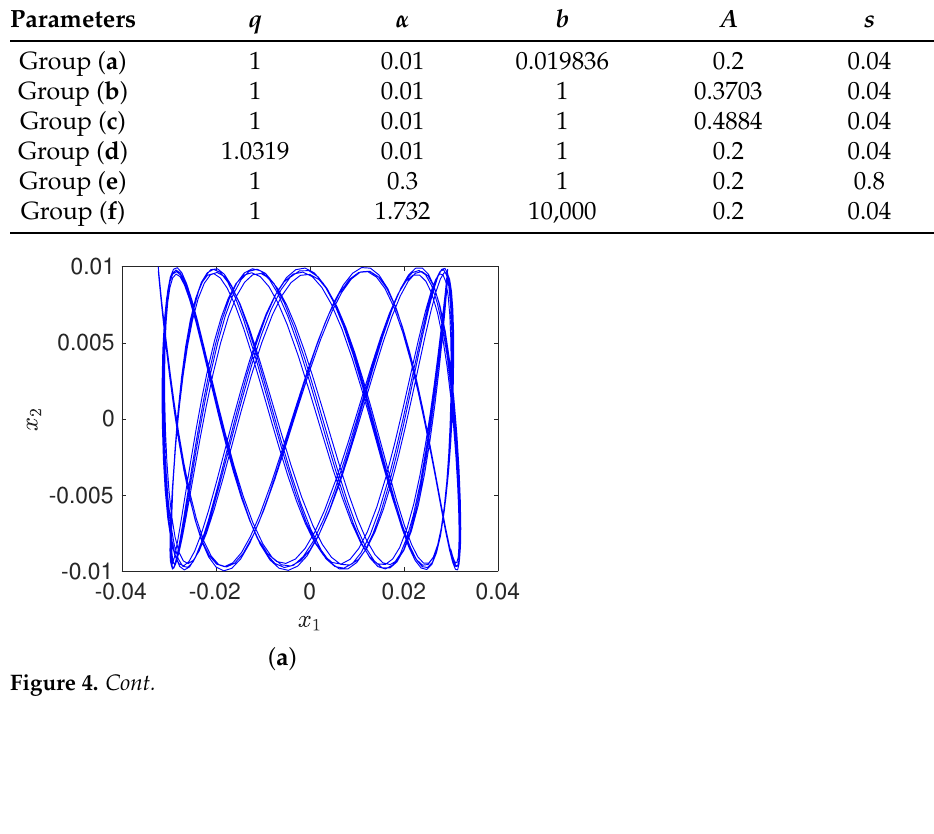
Table 1. Parameter values in the charged dilaton black hole flow.